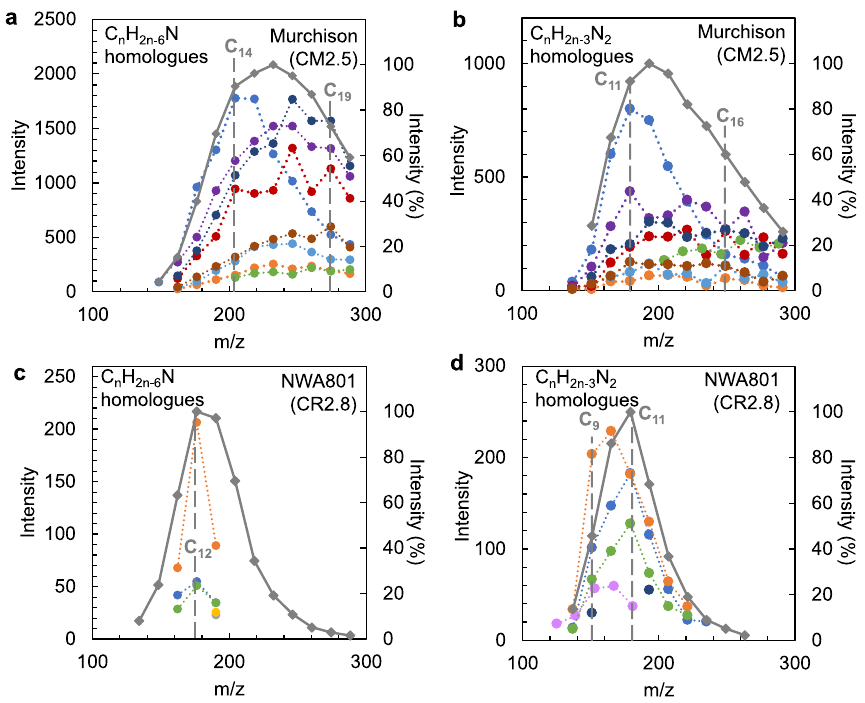
Figure 6. Intensities of the CHN compounds at different micro-spots and overall. ( a ) C n H 2n−6 N homologs in the Murchison meteorite. ( b ) C n H 2n−3 N 2 homologs in the Murchison meteorite. ( c ) C n H 2n−6 N homologs in the NWA 801 meteorite. ( d ) C n H 2n−3 N 2 homologs in the NWA 801 meteorite. Filled colored circles with dotted lines represent the profile from micro-spots. Filled diamonds with solid gray lines represent the profile from the entire region of the samples, shown in percentage